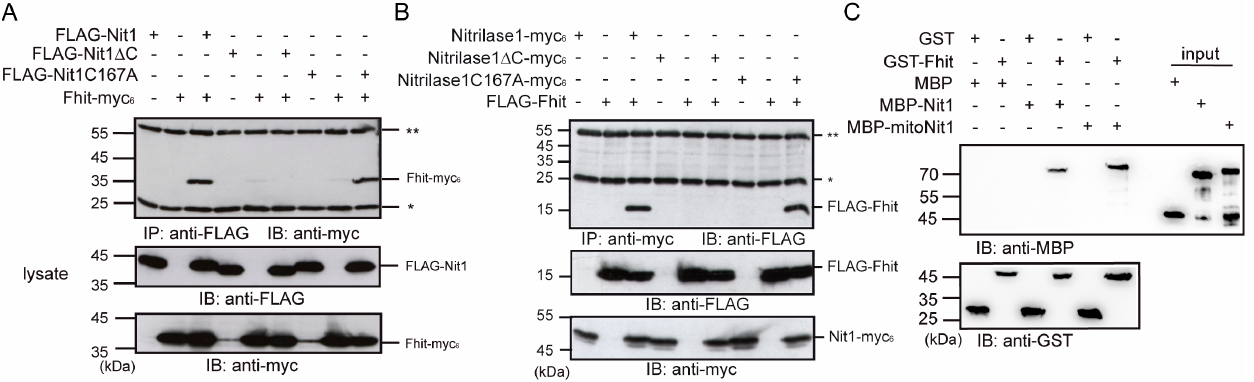
Figure A3. ( A , B ) Co-immunoprecipitation of FLAG- and myc-tagged Fhit and Nit1 variants over- expressed in HEK-293 cells as indicated. Lysate controls are shown in lower panels. The co-immuno- precipitations were performed with the same lysates as shown in Figure 4A and thus the images of the lysate controls are identical. ( C ) GST pull-down assay of Nit1 isoform 4 (MBP-Nit1) or isoform 1 (MBP-mitoNit1) with GST-Fhit. Input of MBP or MBP fusion proteins are shown at the right site. All blots are representatives of at least three independent experiments. * light chain and ** heavy chain of precipitating antibody.